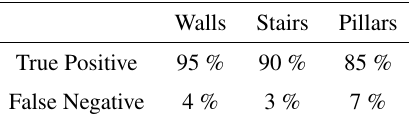
Table 2. Evaluation of the